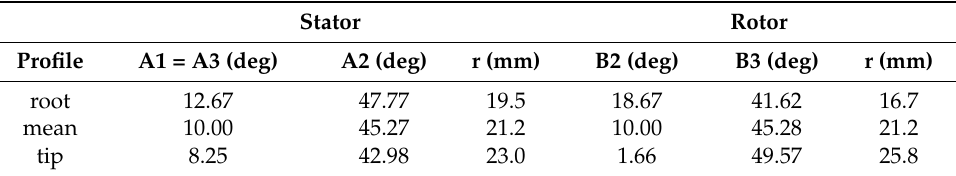
Table 5. Preliminary design parameters for stator and rotor blades.